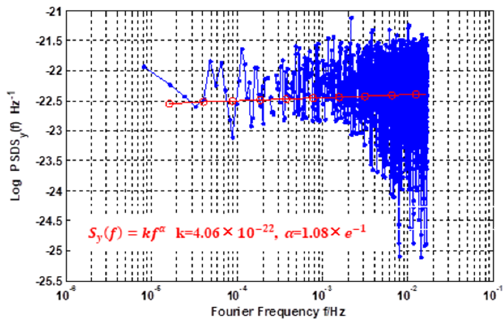
Figure 6. Power spectral density result of simulated frequency.